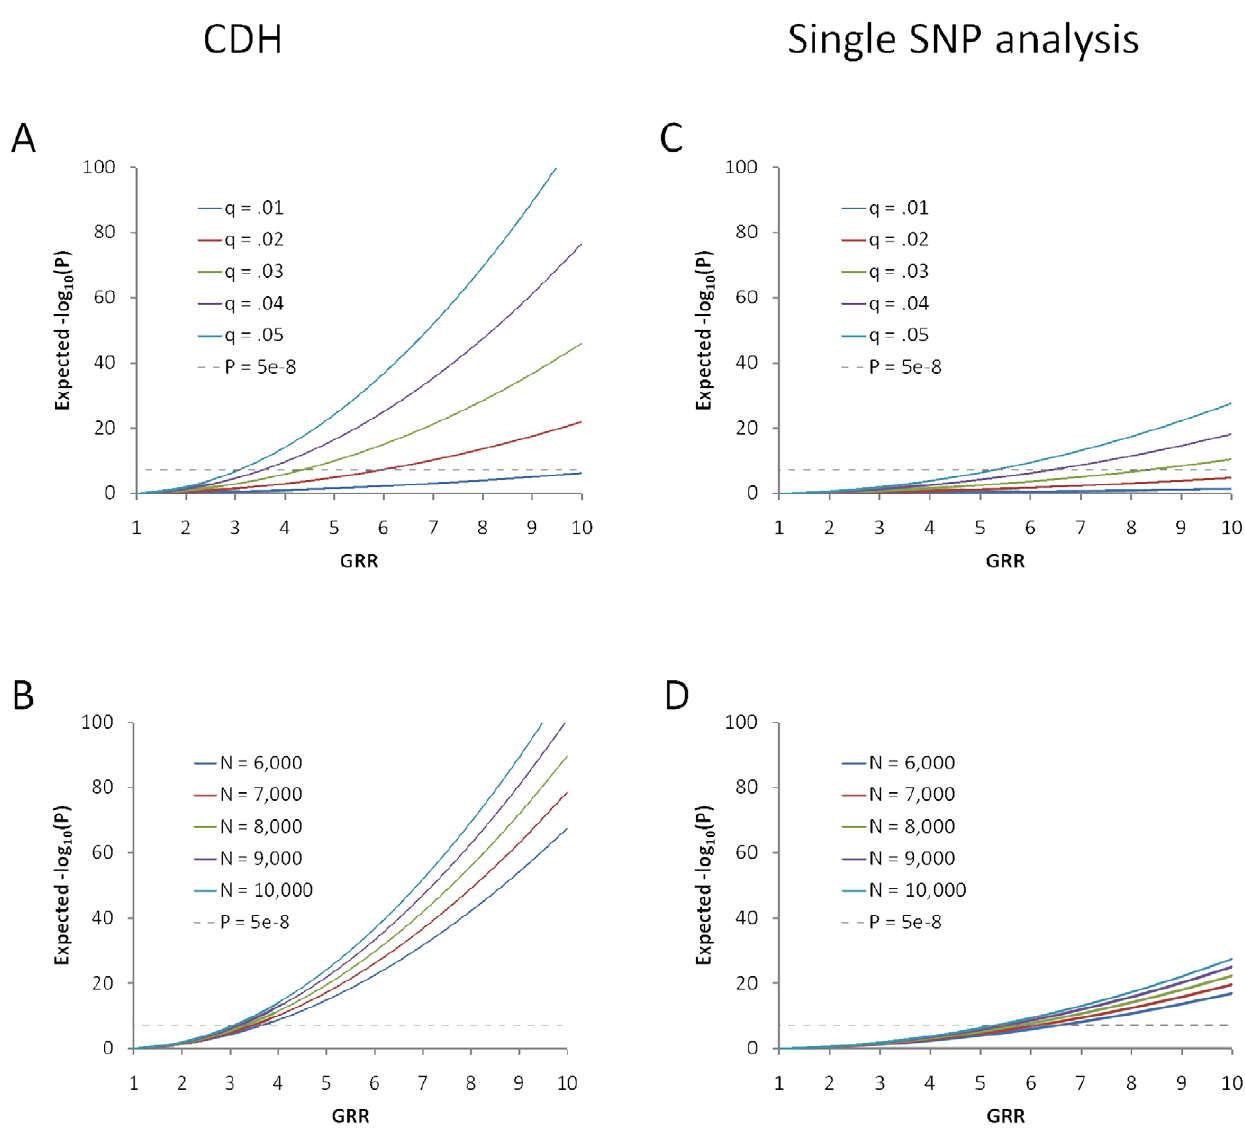
Figure 2. The expected P values for the CDH test. The 2 log 10 (P) values for two causal SNPs (on the left part of the figure, A and B) and for the single SNP chi-squared test (on the right part, C and D) are derived as a function of the genotype relative risk ( GRR AA = GRR BB = GRR AaBb ranging from 1 to 10), the minor allele frequencies ( q = q 1 = q 2 ranging from 0.01 to 0.05 when N is fixed at 10,000; A and C), and the total sample size N (ranging from 6,000 to 10,000 when q is fixed at 0.05; B and D). The base line prevalence of a binary phenotype is fixed at 5% in all analyses.